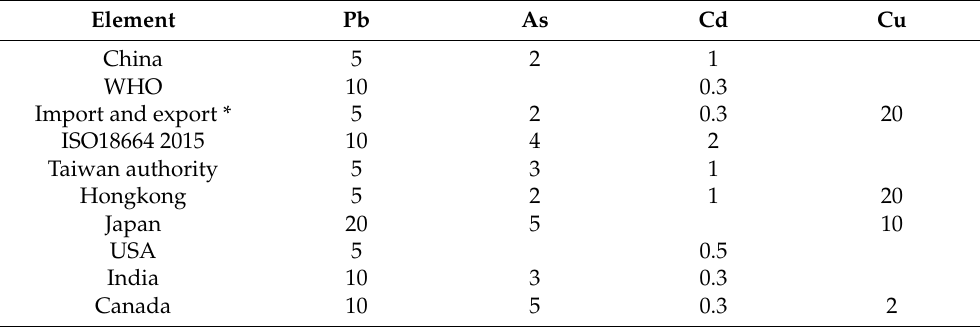
Table 1. The standard for Chinese medicinal materials in terms of the total concentrations of trace elements (unit: mg/kg). Element Pb As Cd Cu China 5 2 1 WHO 10 0.3 Import and export * 5 2 0.3 20 ISO18664 2015 10 4 2 Taiwan authority 5 3 1 Hongkong 5 2 1 20 Japan 20 5 10 USA 5 0.5 India 10 3 0.3 Canada 10 5 0.3